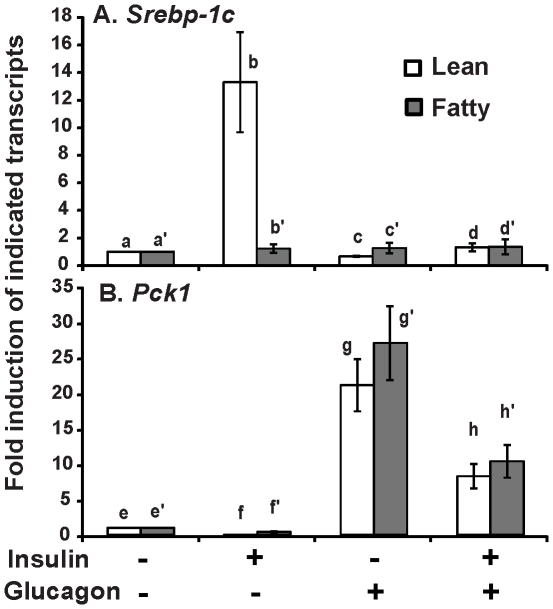
The effects of insulin and glucagon on the mRNA levels of Srebp-1c (A) and Pck1 (B) in hepatocytes from ad libitum Zucker lean and fatty rats.Primary hepatocytes after pretreatment as described in Materials and Methods were incubated in medium A without or with 10 nM glucagon in the absence or presence of 100 nM insulin for 6 hours. Total RNA was extracted and subjected to real-time PCR analysis. The expression level of the indicated transcripts in the control hepatocytes (lean or fatty) was arbitrarily assigned a value of one for its corresponding cell type. Results were plotted as fold induction and presented as means ± SD of five independent hepatocyte isolations for both lean and fatty rats (n = 5 for hepatocyte isolations; for Srebp-1c, b>a>c, b>d, b>b′, and c′>c, using one-way ANOVA; for Pck1, g>h>e>f, g′>h′>e′>f′, and e′>e, using one-way ANOVA; all P<0.05).